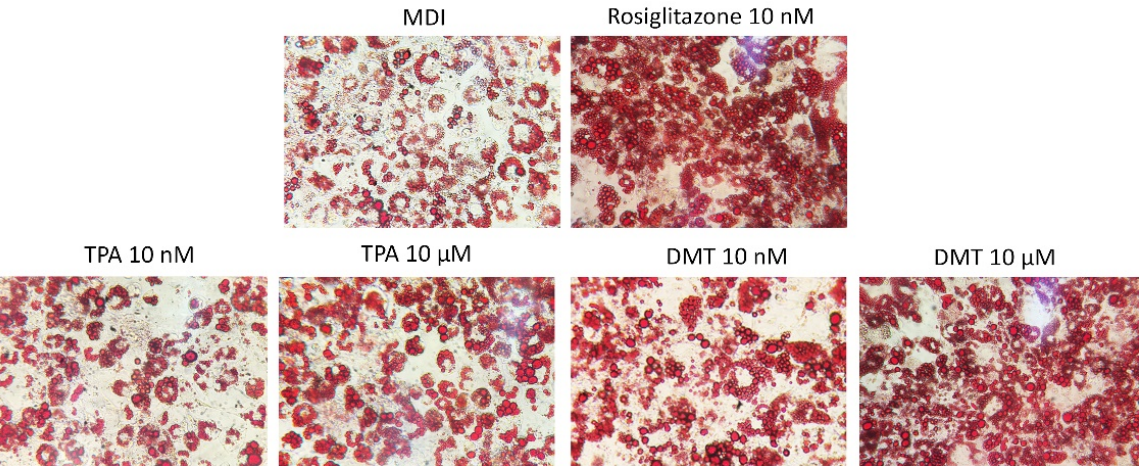
Figure 2. Oil Red O staining. 3T3-L1 preadipocytes were cultured in differentiation medium (MDI) containing phthalates (10 nM and 10 µM) or rosiglitazone (10 nM, positive control) for 10 days. Cells treated with MDI alone were used as controls. The cells were then stained with Oil Red O and photographed using an optical microscope (original magnification at ×40). The images are representative of three independent experiments.